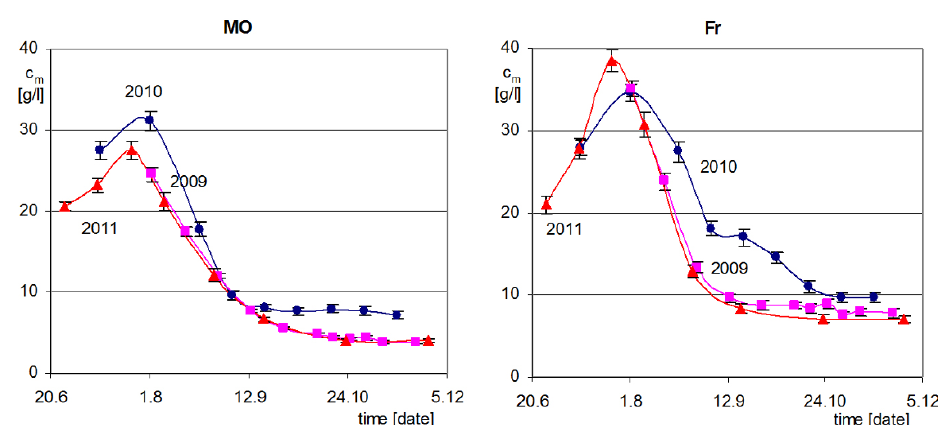
Figure 2. Changes of titratable acidity in Muscat Ottonel (MO) and blue Frankish (Fr) grapes in 2009, 2010, and 2011.